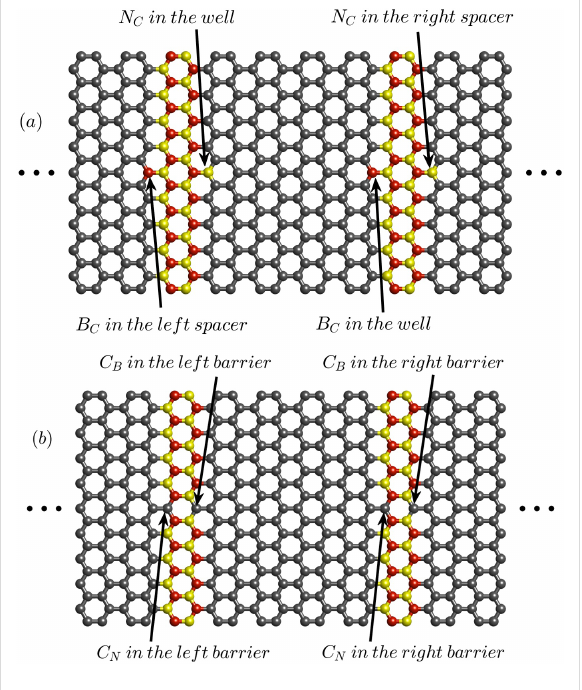
Figure 2: All possible substitutional defects at the interfaces of RTD based on AGNR/ABNNR heterojunctions. Carbon, boron and nitrogen atoms are depicted in grey, red and yellow,